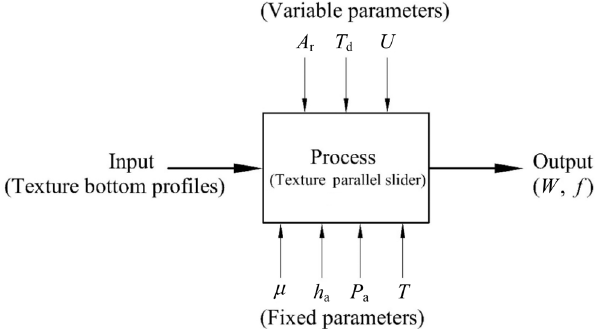
Fig. 5 Model of the process.